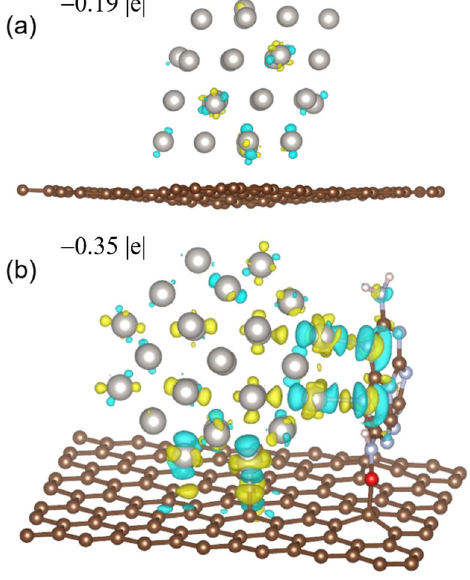
Figure 7. The charge density difference (isosurface unit = 4 × 10 − 3 e per Bohr 3 ) and Bader charges of Pt 40 NCs of ( a ) Pt 40 /C and ( b ) Pt 40 /MMC. The yellow and blue surface represent the charge increase and decrease, respectively. The Bader charges of the Pt atoms at the marked adsorption sites for OOH* and OH − * on Pt/C with an average value of − 0.049 |e| are less than that on Pt/MMC (with an average value of − 0.077 |e|). Reproduced with permission, Copyright 2022 Wiley ‐ VCH GmbH [116] .